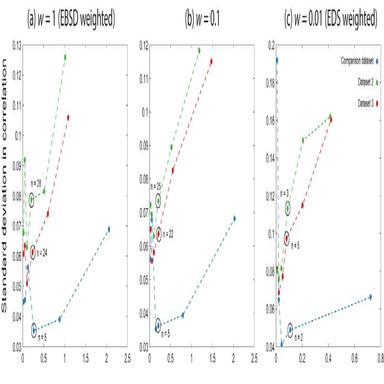
Standard deviation of normalised cross-correlation between measured EBSPs and spectra with their associated characteristic EBSPs and spectra, combined in quadrature. Shown for three alloys and three EBSD weighting parameters. As more principal components are retained, correlation initially improves as AOIs are better matched. After reaching the optimal level correlation degrades as principal components corresponding to noise are included in the VARIMAX rotation. The trend is stable (the minimum occurs in ap